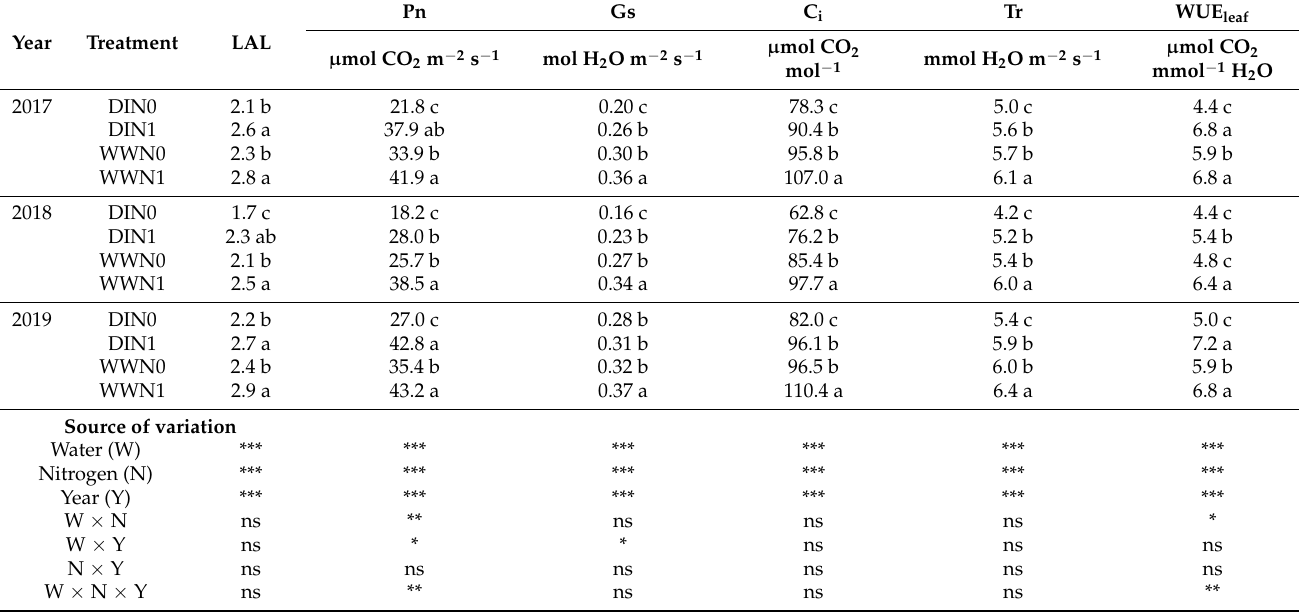
Table 1. Effects of N fertilization and seedling-stage deficit irrigation (DI) on leaf area index (LAI) and net photosynthetic rate (Pn), stomatal conductance (Gs), intercellular CO 2 concentration (Ci), transpiration rate (Tr) and leaf instantaneous water use efficiency (WUE leaf ) of maize plant after DI period in